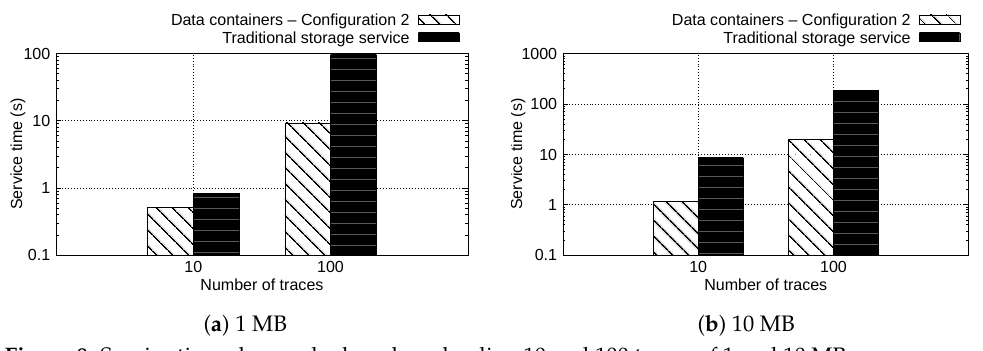
Figure 8. Service time observed when downloading 10 and 100 traces of 1 and 10